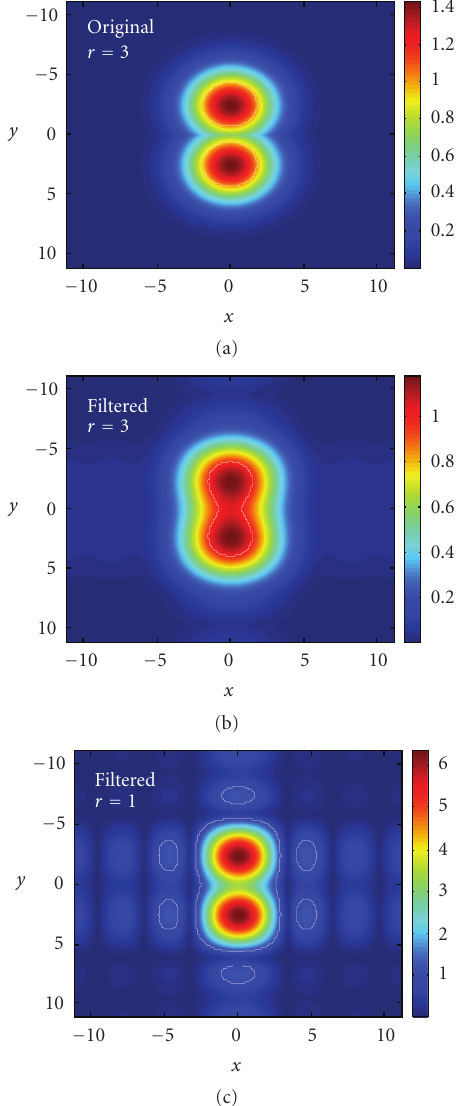
Figure 5: Value of the density map before (continuous gray line) and after (dashed black line) filtering at a point belonging to both the SES and the VdWS, c 1 (a) a point belonging to the SES but not the VdWS, c 2 (b) and a point outside the molecule, c 1 (c) (see Figure 4). t = 1, so, when r = 3, conditions (5) are satisfied.